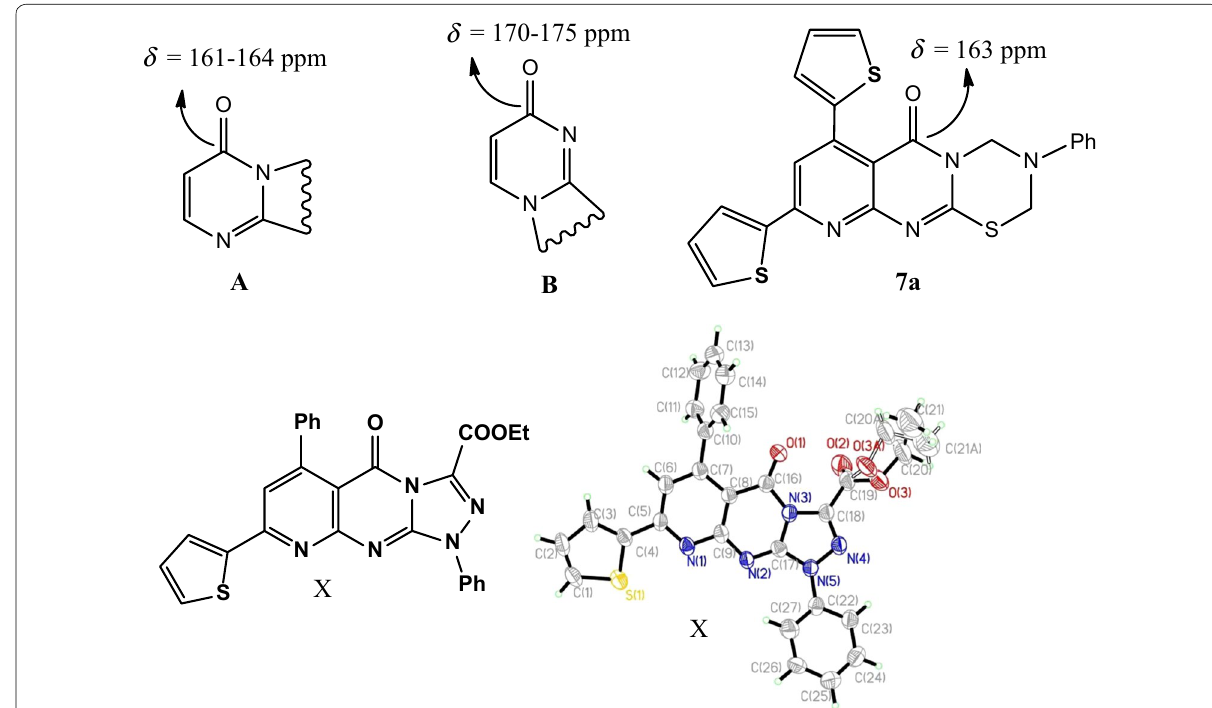
Fig. 1 The strategic structures of the products ( 7a – g